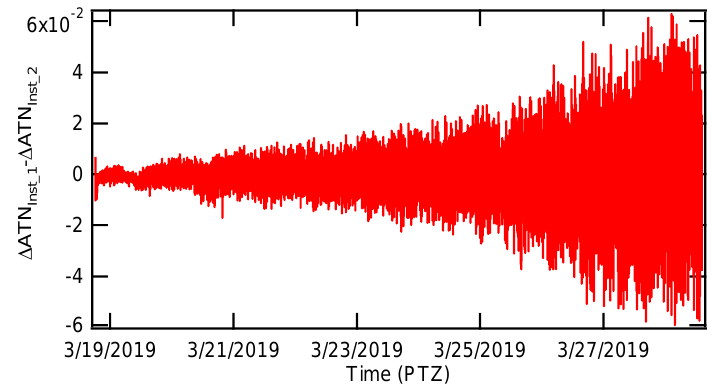
Figure 8. Difference of ∆ATN (attenuation) between Inst_1 and Inst_2.